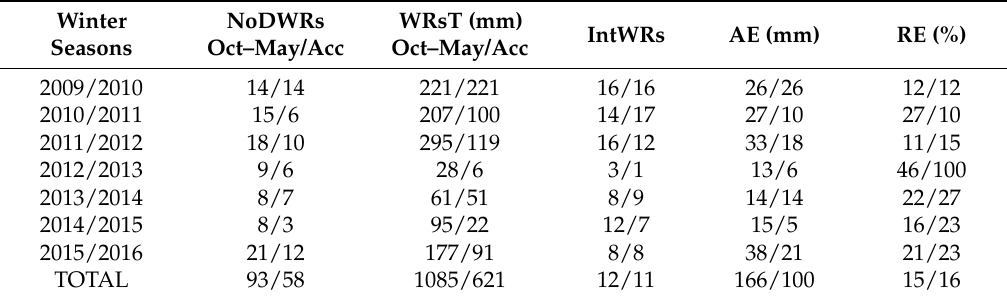
Figure 8. Spatial distribution of cumulated winter rain totals (mm) between October and May 2009–2016 for: ( a ) whole period, and ( b ) when winter rain occurred following snow accumulation. Table 2. Characteristics of winter rainfalls (WRs) on Hansbreen during winter (Oct–May), and during the period of snow accumulation (after snow cover forming) on the glacier.